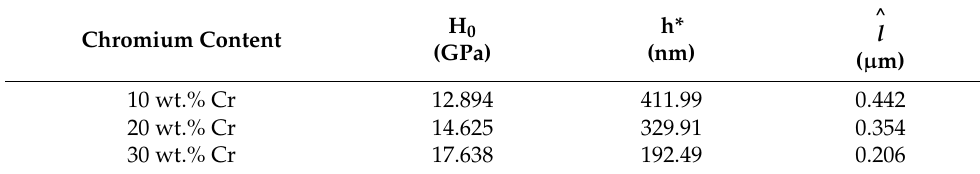
Table 3. Length scale parameters estimated based on Nix and Gao model from the fitted nanoinden- tation results obtained in the measuring area containing 10, 20 and 30 wt.% of